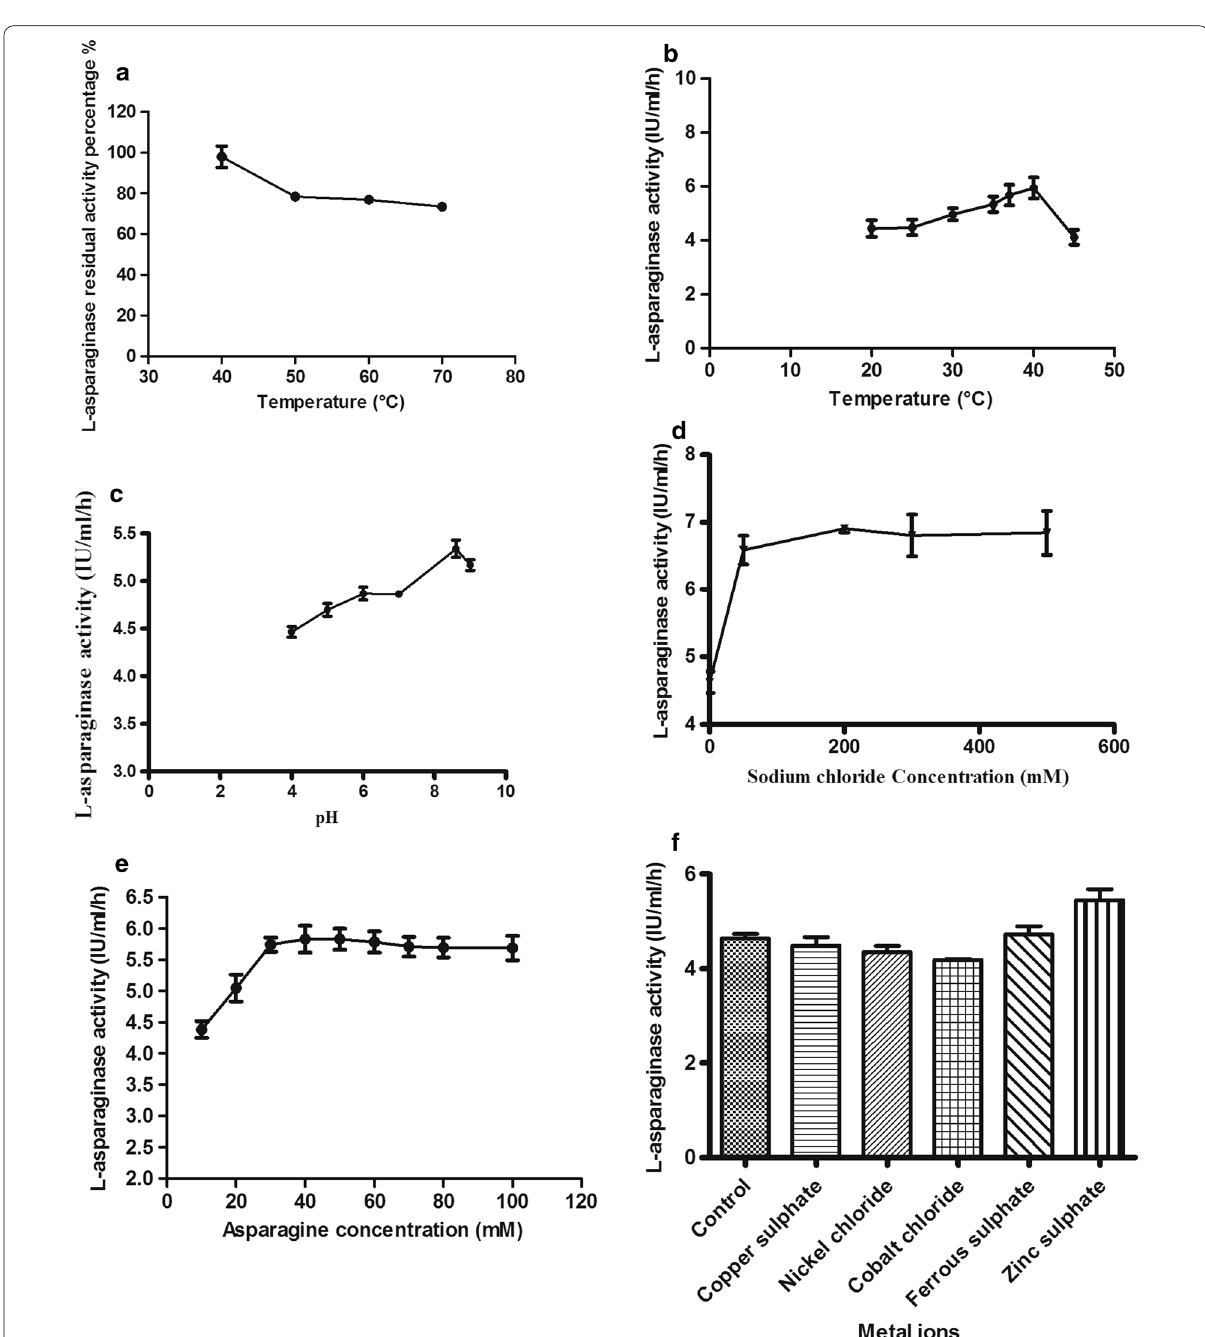
Fig. 3 Thermal stability ( a ) and catalytic activities at different temperatures ( b ), pH values ( c ), salinities ( d ), substrate concentrations ( e ) and metal ions ( f ) of l -asparaginase produced by Bacillus